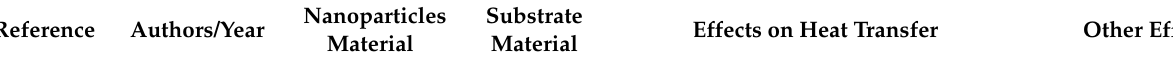
Figure 1. Nanoparticle deposition time-dependent features at play. Table 1. Main recent experimental works on boiling-induced nanoparticle